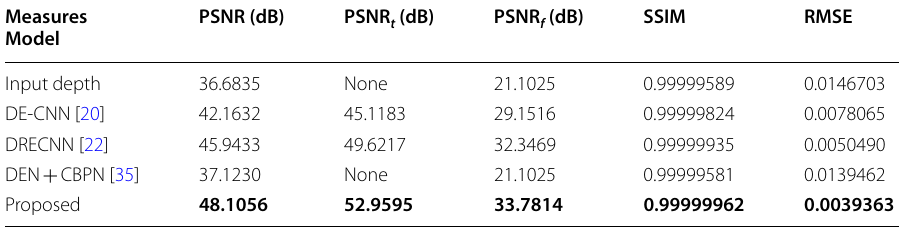
Table 1 Performance comparisons in scene flow testing set Measures